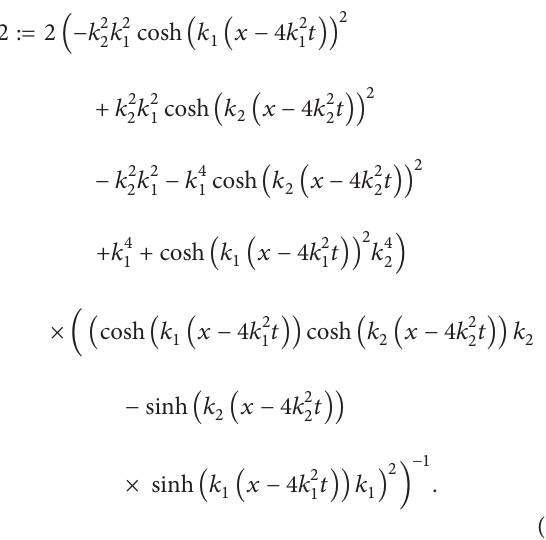
to the appearance of a window of a tripled period.